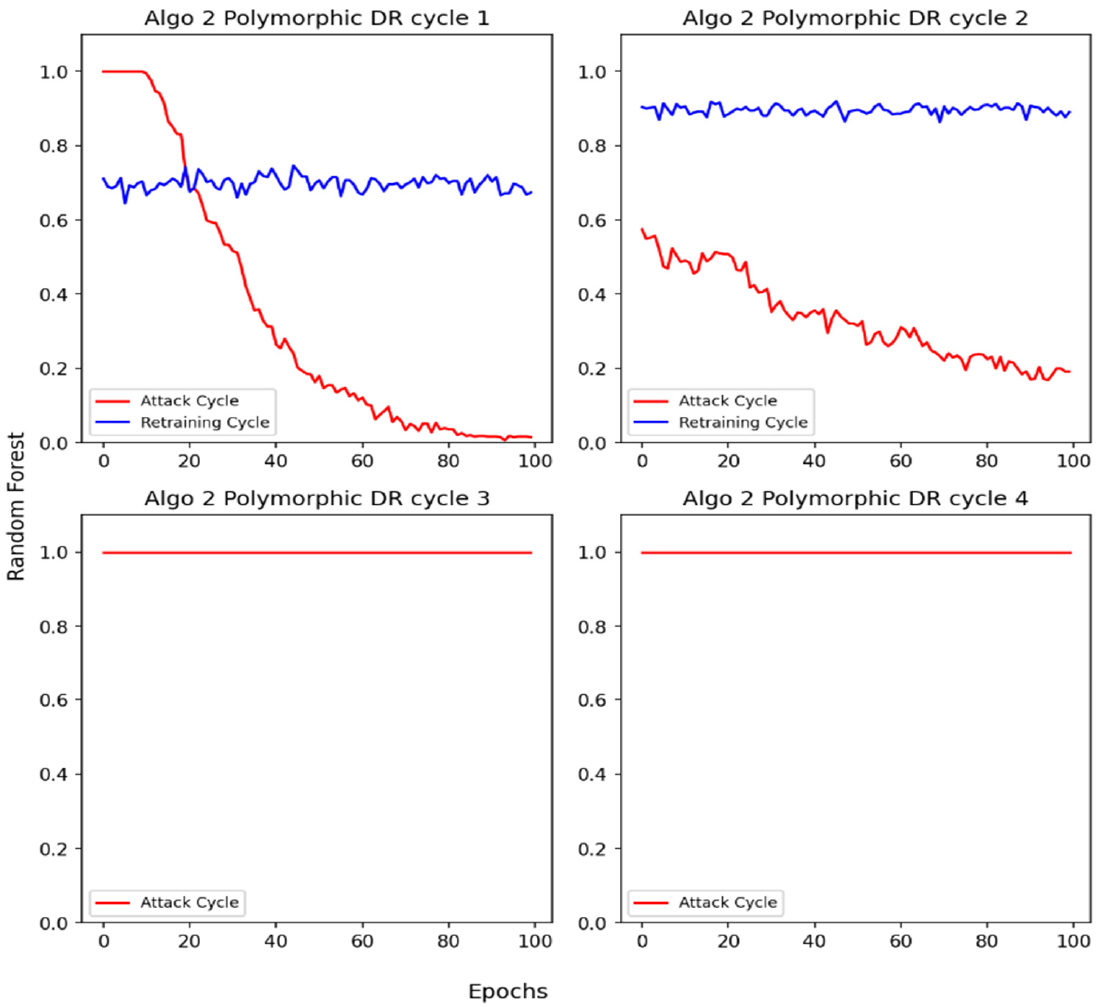
Figure 7. Polymorphic adversarial DDoS/DoS attack using Algorithm 4 .